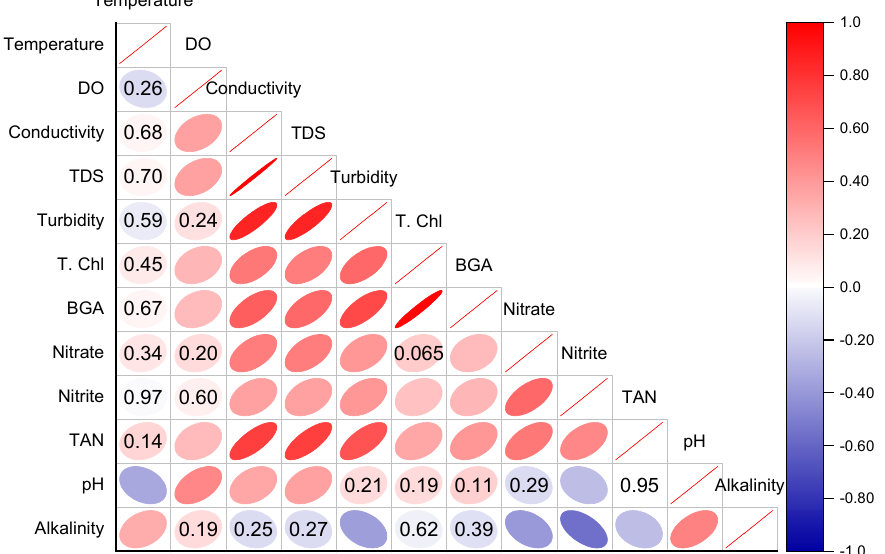
Figure 3. Correlation plot represented as a dot plot for the associations between the water quality variables recorded in the biofloc ‐ based rearing of O. bimaculatus . The color difference/intensity represents the degree of correlation between them based on Pearson’s correlation coefficient (values indicated inbox as per the colour intensity indicated on the right column ranging from − 1.0 to 1.0). Values indicated in dots are insigni fi cant p ‐ values.